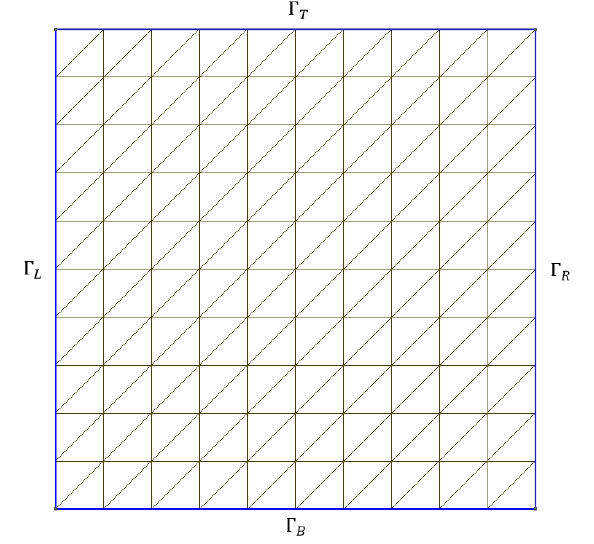
Figure 3. Computational domain.